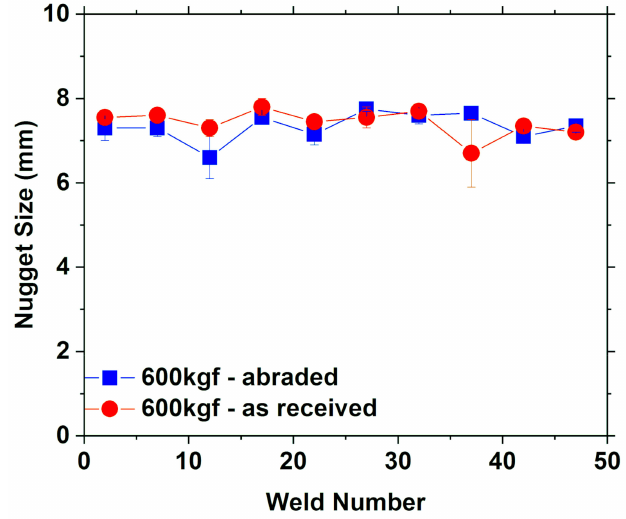
Figure 8. Measured nugget size during continuous RSW under the electrode force of 600